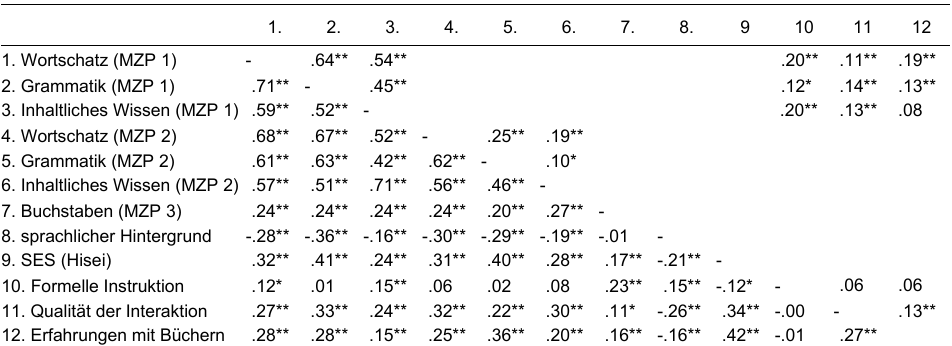
Tabelle 1: Im Rahmen des Pfadmodells spezifizierte Korrelationen (oberhalb der Diago- nale) sowie bivariate Korrelationen zwischen den Kompetenz-, Hintergrund- und HLE-Variablen (unterhalb der